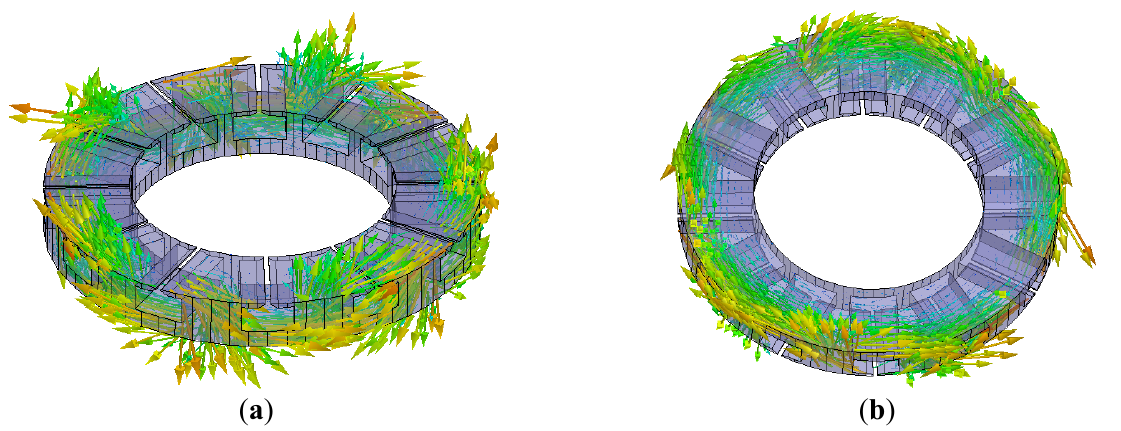
Figure 8. The magnetic flux density distributed in the yoke: ( a ) rolled lamination ( b ) SMC.